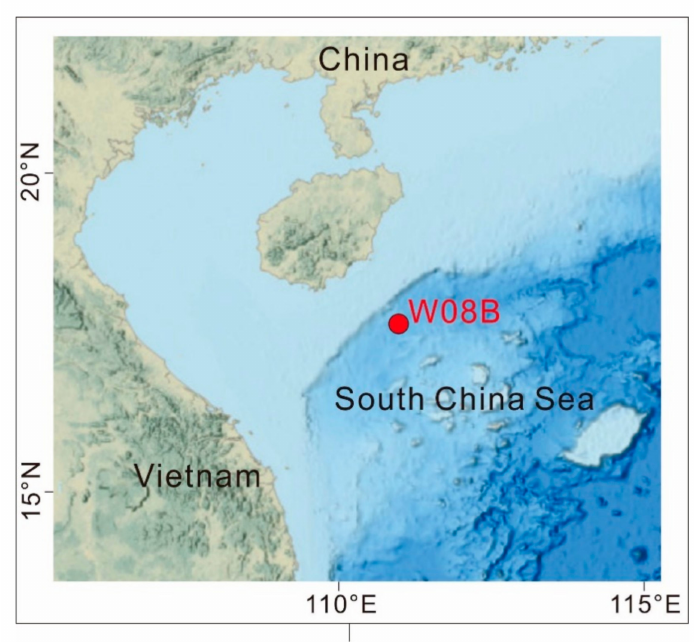
Figure 1. Location of the drill site GMGS5-W08B. The topographic map and inset map were obtained from the website https: // maps.ngdc.noaa.gov / viewers / fishmaps /